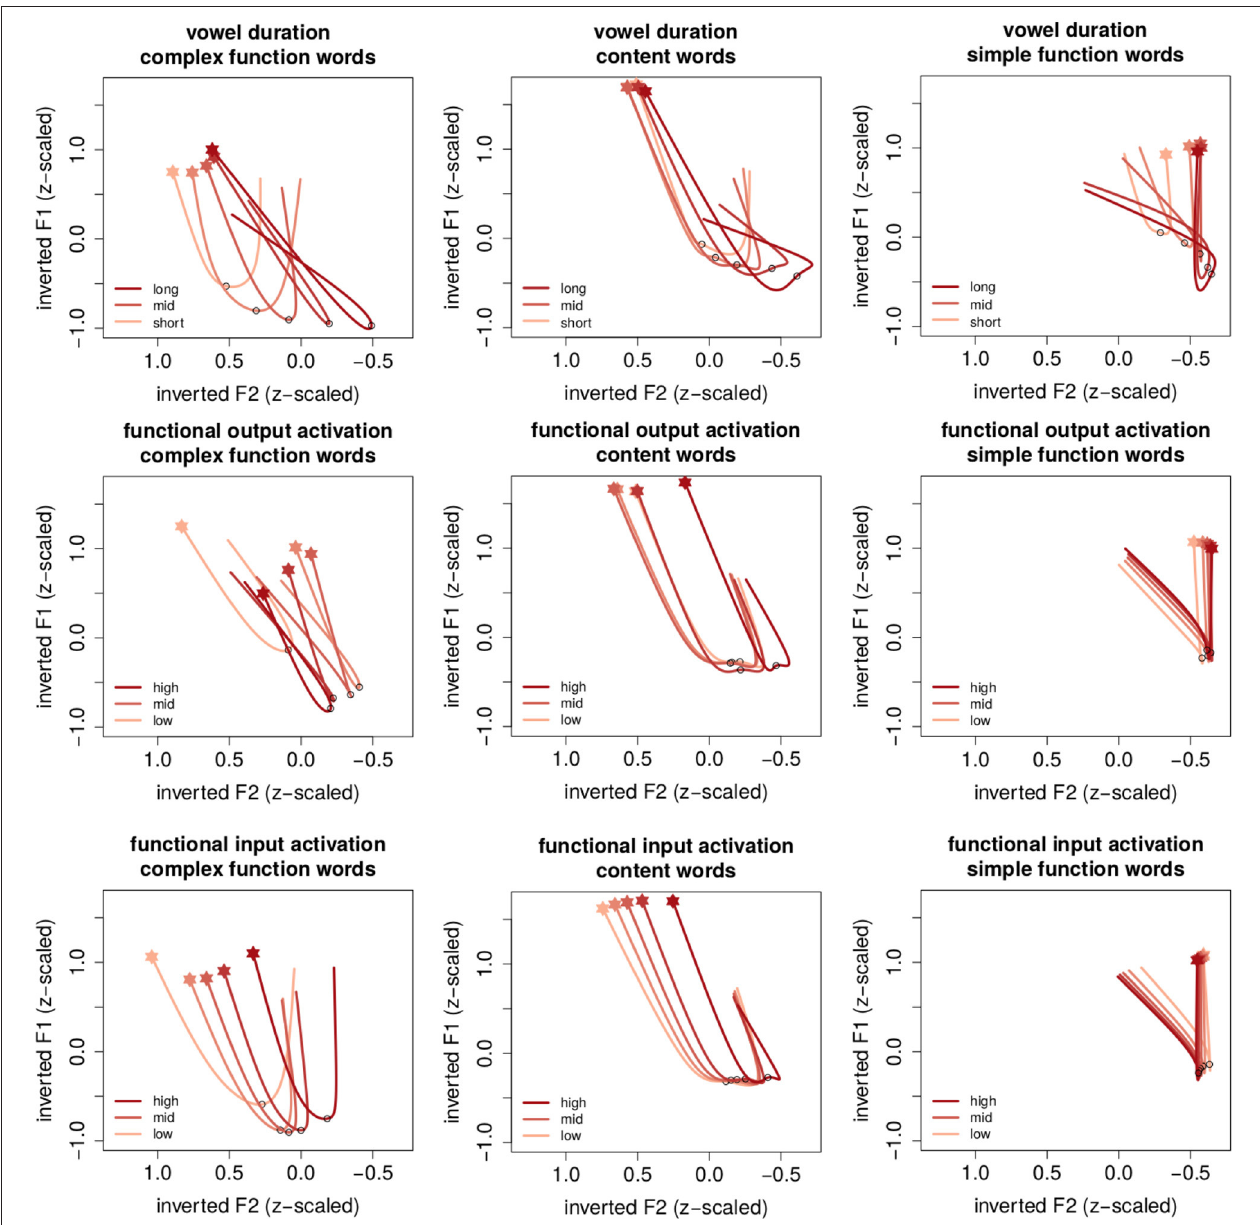
FIGURE 3 | Estimated trajectories for different word classes (columns) in relation to vowel duration (top) , functional output activation obtained from a network with inflectional functions of [ 5 ] in the output (middle) and functional input activation obtained from a network with inflectional functions of [ 5 ] in the input (bottom) . The x-axes represent inverted z-scaled F2 frequencies such that the left edge points toward the front of the vowel space and the right edge points toward the back of the vowel space. Y-axes represent inverted z-scaled F1 frequencies such that the top points to the top of the vowels space and the bottom points toward the bottom of the vowel space. Shades of red represent percentiles for different predictors (optimized for color blindness). Onset of the time course is located at the filled star, the circle in the trajectory represents the center of the